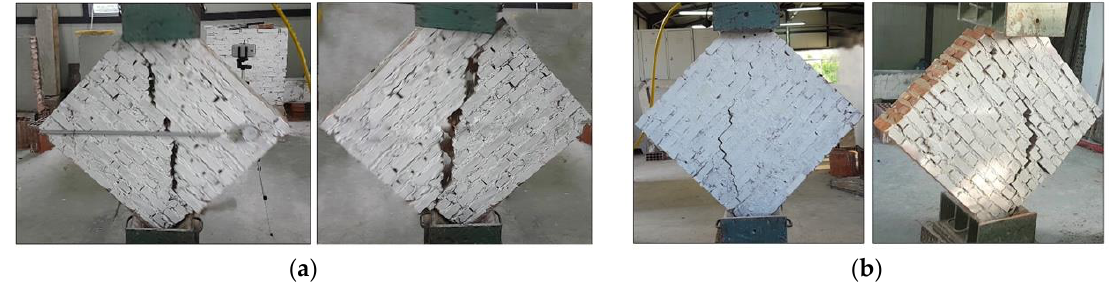
Figure 13. Failure mode of wall panel W-1-URM.